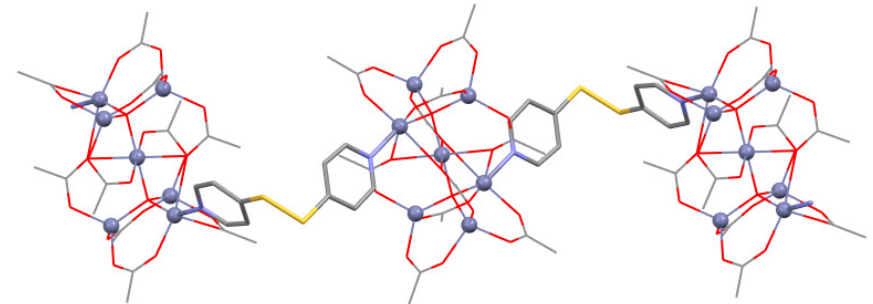
(CH COO) ( μ -O) ( μ - dtdp )] 7 3 10 4 2